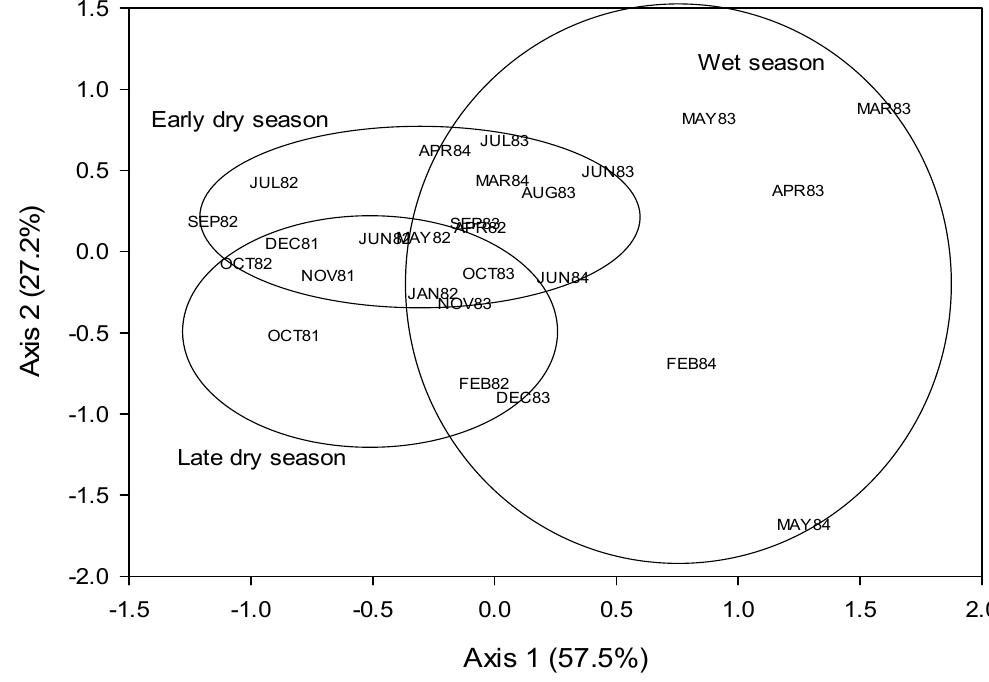
Figure 3. NMDS analysis of invertebrate data for October 1981–June 1984, showing significant seasonal groupings, indicated by MRPP analysis (see text). Proportion (%) of variance explained by each axis is shown. Stress =